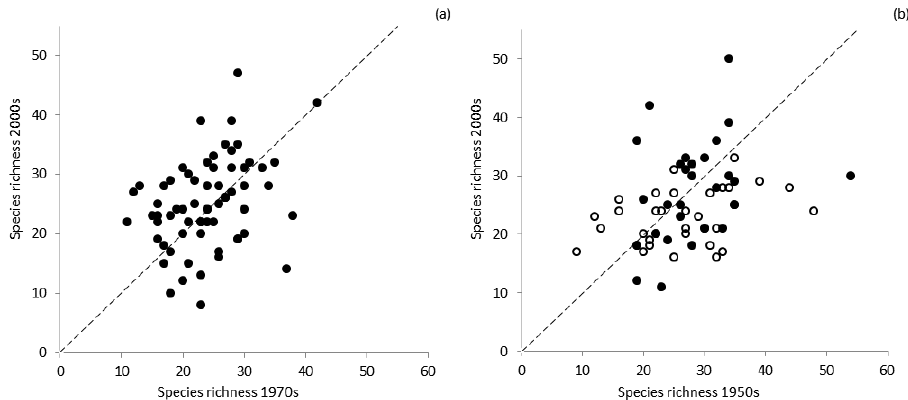
Figure 2. Past and present species richness of sampling plots. The dashed lines present a hypothetical situation in which the sampling plots had the same numbers of species between the two surveys. ( a ) Forest in the Sanocko-Turczanskie Mountains; ( b ) forest in the in the Western Bieszczady Mountains; filled circles: managed; open circles: unmanaged forests. Table 1. A comparison of the species pool of the two surveys in the Sanocko-Turczanskie Mountains and the Western Bieszczady Mountains: the overall number of species recorded in the two surveys, species present in both surveys, species lost or gained between the 1950s/1970s and 2000s. Total Pool of No. of Stable No. of Lost Species Species Species (% of Total Pool)